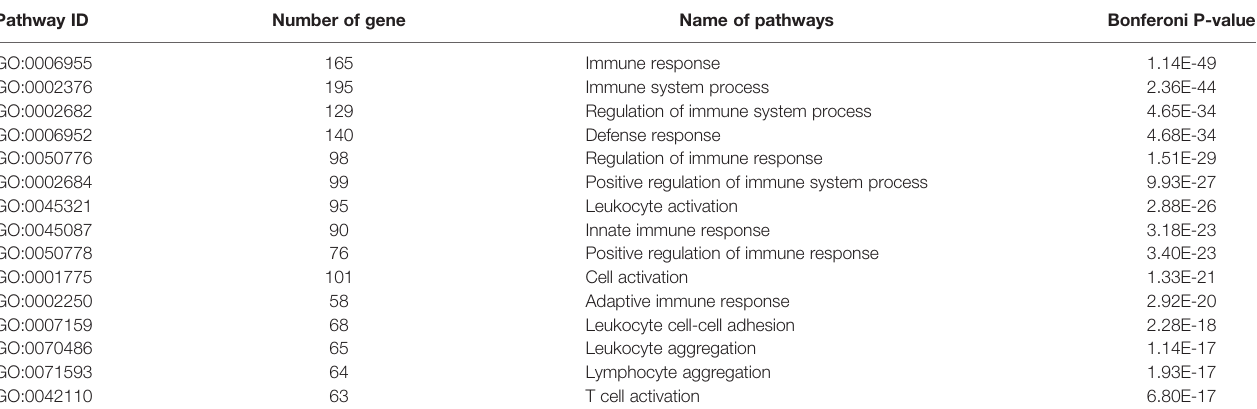
TABLE 1 | GD related key gene co-expression modules — blue module gene function riched GO pathway. Pathway